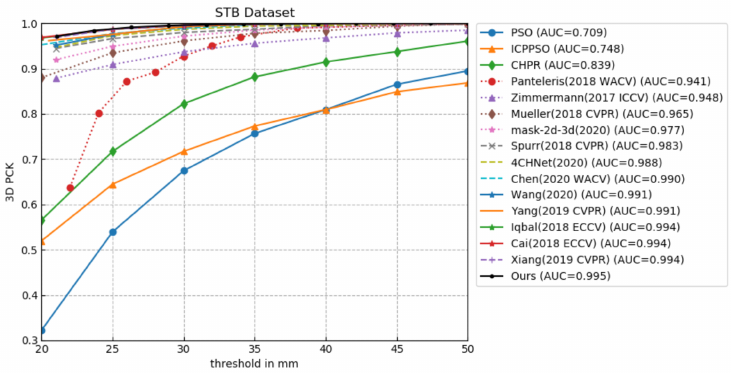
Figure 9. Comparison with the state-of-the-art methods on STB dataset